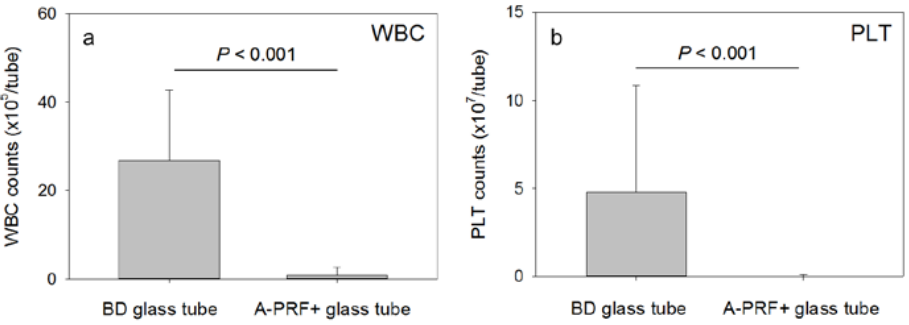
A-PRF/CGF clots prepared in the absence of the anti-coagulant were removed, the inside of the tubes were washed thoroughly. WBCs and platelets were enzymatically detached for counting. N = 8 (A-PRF+ ® ) or 12 (Vacutainer tube ®